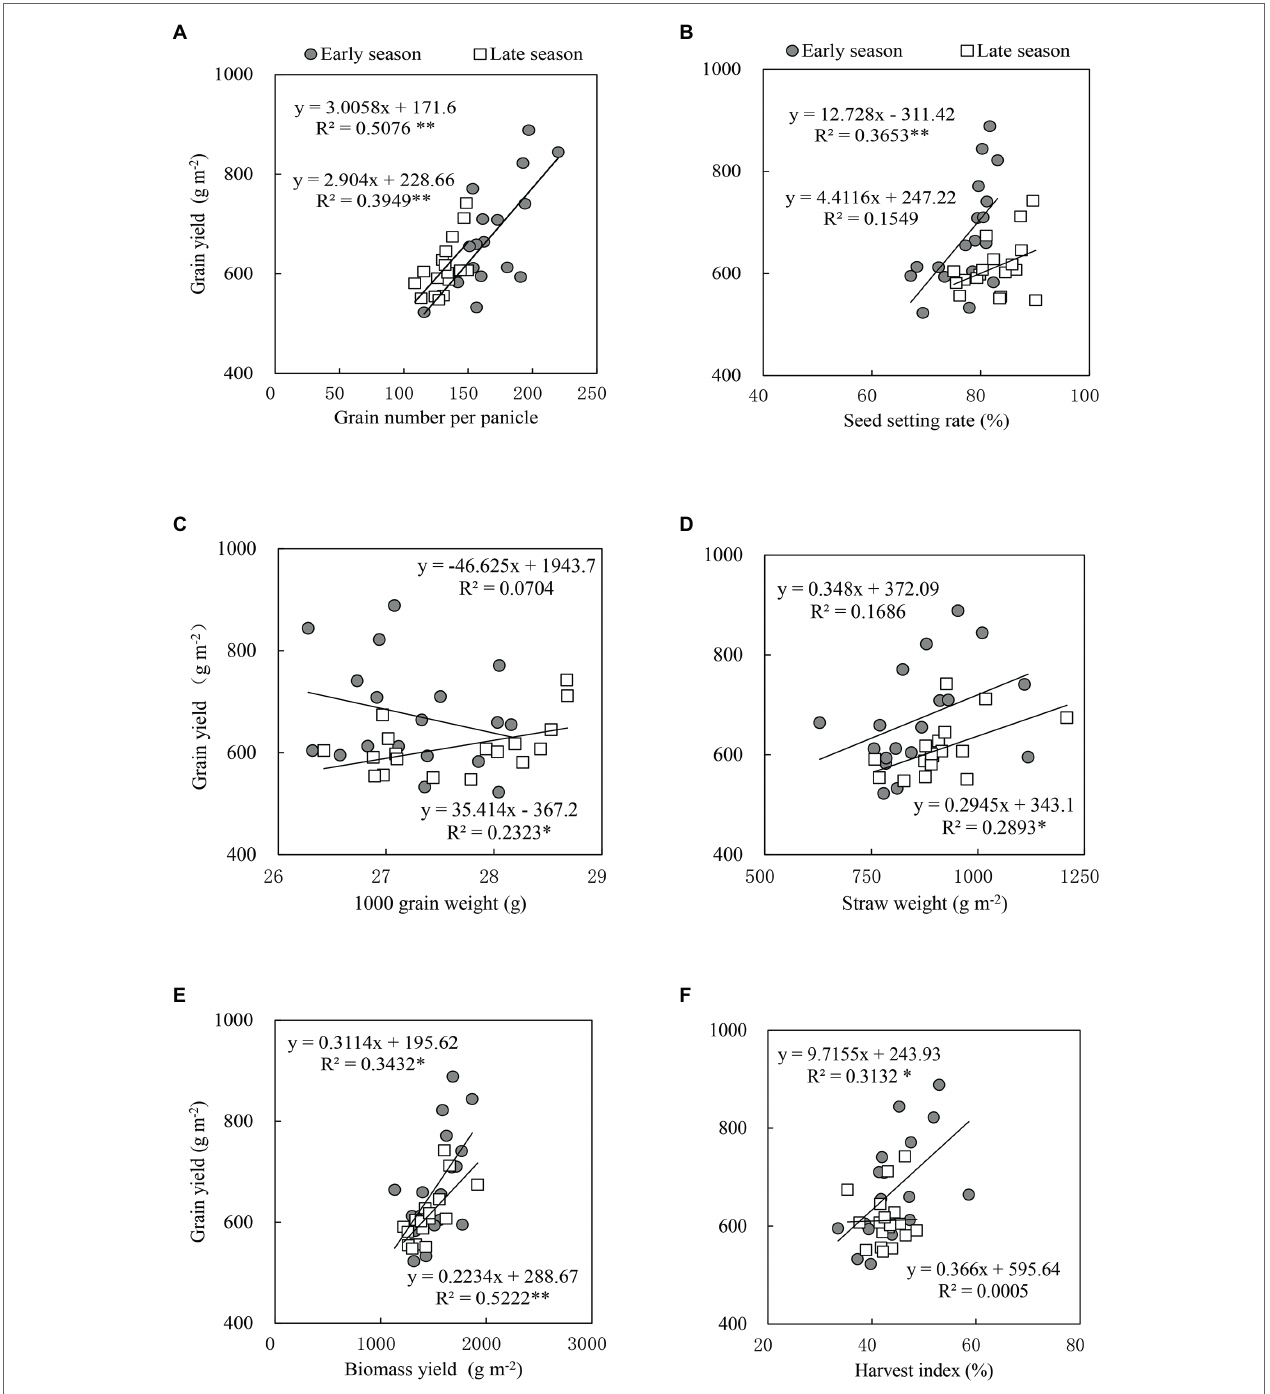
FIGURE 1 | Relationships between grain yield with (A) the number of grains per panicle, (B) seed setting rate %, (C) 1,000-grain weight, (D) straw weight, (E) biomass yield, and (F) harvest index of the early and late season of double rice cropping system in South China. **Significant at p < 0.05; *Significant at p < 0.01. A smaller R 2 value means greater